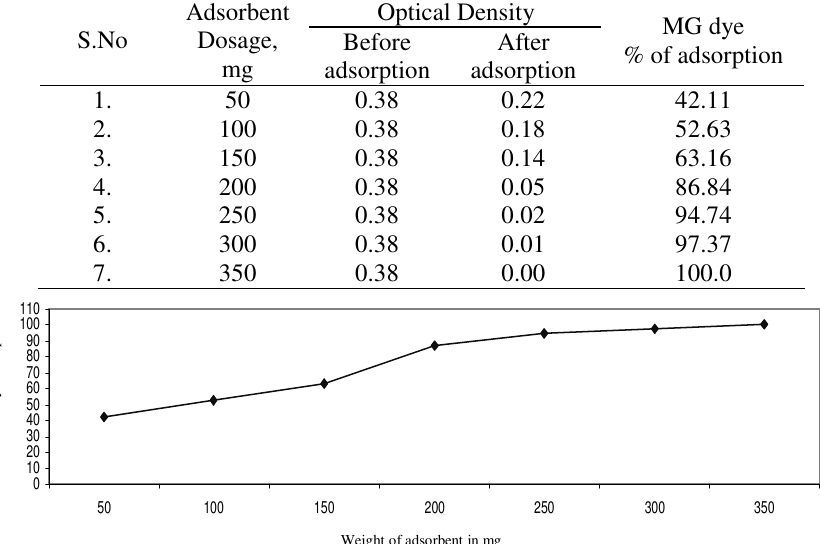
Effect of adsorbent dosage on removal of MG dye ( Initial concentration: 25 ppm) Optical